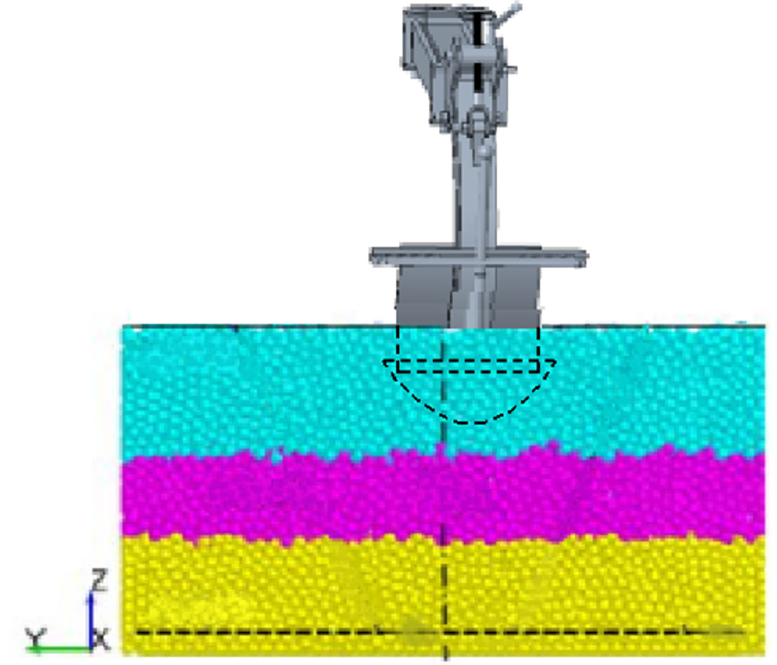
Figure 7. Ditching operation simulation diagram.